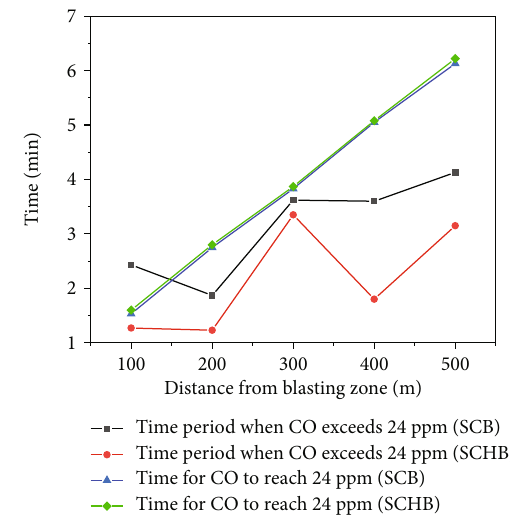
Figure 17: Time taken by CO to reach 24ppm and exceed the same with the monitoring distance in double-hole SCB and